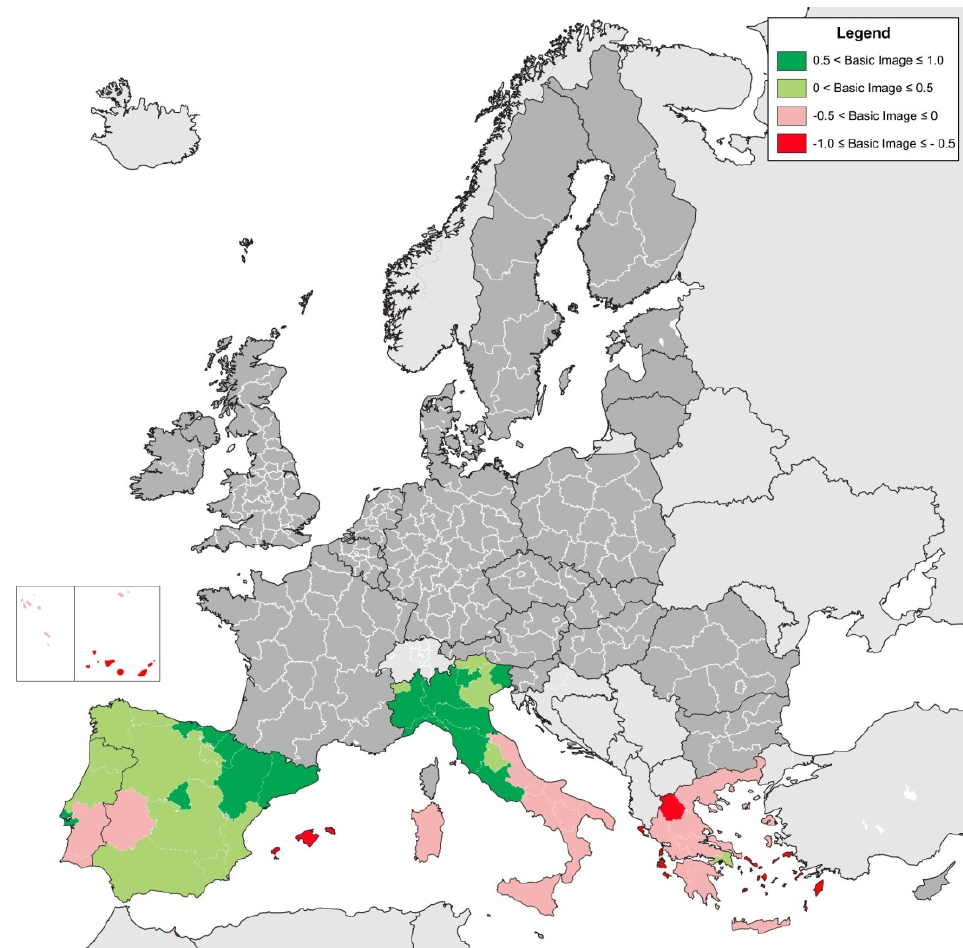
Figure 3: Classification of the south European regions according to their Basic Image